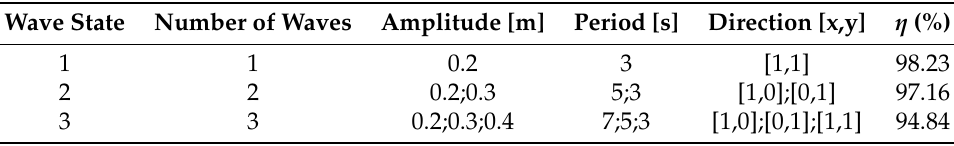
Table 2. The selected wave parameters were based on realistic values that can be measured in the different wave states. While there is generally a correlation between wave height and period, the shorter periods for some large waves reflect how the platform may respond to rapid changes in steepness. All the tests were conducted over 30 s. The resulting plots are shown in Figure 12. The machine conducting the simulations has an i5-10600K CPU @ 4.10 GHz, a GeForce RTX 2060, and 15.5 GiB memory, running ROS Noetic and Gazebo 11.